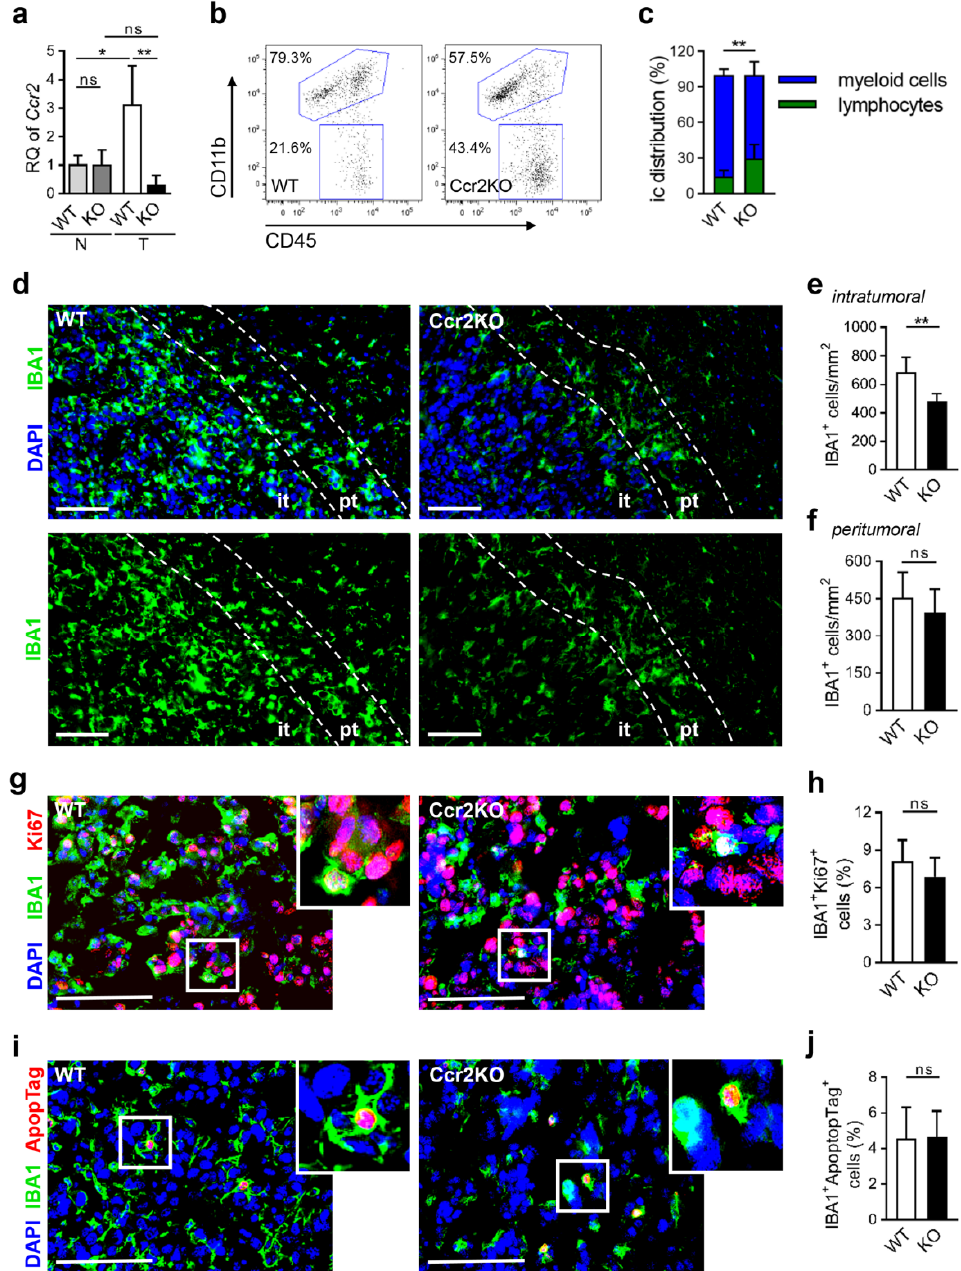
Figure 2. IBA1 + cells accumulate less in tumor-bearing Ccr2 -deficient mouse brains. ( a ) RT-PCR for Ccr2 of CD11b + cells from naïve (N) and tumor-bearing (T; d21) brain tissues of the wildtype (WT), as well as Ccr2KO (KO) mice, is presented (n = 3–4). ** p < 0.01; * p < 0.05; ns, not significant (one-way ANOVA and Bonferroni’s multiple comparison test). ( b ) Tumor-bearing brains of WT and Ccr2KO mice (d21) were analyzed by flow cytometry. Representative dot plots show gates for TAMs (CD11b + CD45 + ) and lymphocytes (CC11b - CD45 + ). ( c ) The graph depicts the calculation of myeloid cells and lymphocytes (n = 10–11). ( d ) Tumors of WT and Ccr2KO brains were analyzed via immunofluorescence staining for myeloid cells (IBA1 + ; d21). Representative images of the tumor border are depicted. Dashed lines define the peritumoral area (pt; 100 µm region from tumor border into normal brain tissues) and surround the intratumoral area (it). Scale bars 100 µm. ( e,f ) The calculation for the number of IBA1 + cells within the it ( e ) and pt ( f ) area are illustrated (n = 6). ( g,i ) Representative images of immunofluorescence staining for IBA1 and Ki67 (g) or apoptosis (i) in the tumor area of WT and Ccr2KO mice (d21). Squares illustrate magnified areas. Scale bars 100 µm. (h,j) Graphs depict rate of proliferation (h) and calculation of apoptotic IBA1 + cells (j) (n = 6). ** p < 0.01; ns, not significant (unpaired Student’s t -test).